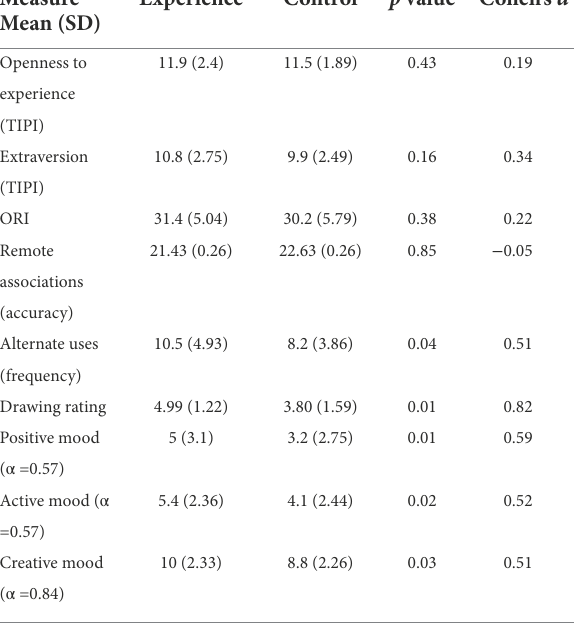
TABLE 1 Condition means for individual differences, task performance, and mood measures. Measure Mean